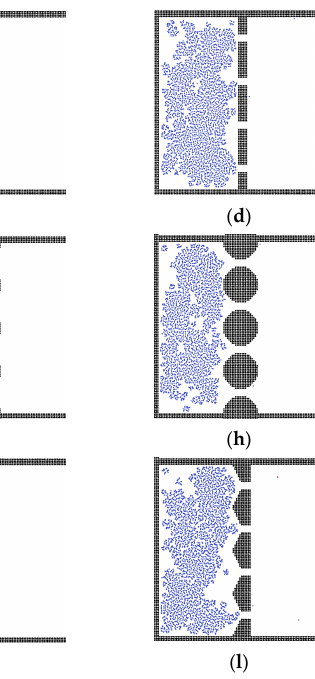
Figure 5. The results with different channel sizes; ( a , b,e , f , i , j ) with channel width of 12 μ m; ( c , d ), ( g , h , k , l ) and with channel width of 20 μ m. The fluid flow was affected by the channel surface, and we calculated different mod- els in order to explain the effects of membrane thickness. For the thin membrane structure, as shown in Figure 6, oil particles adsorb on the corner, which is similar to that previously discussed. However, using a thicker membrane structure, Figure 6d shows more residual oil particles, and the structure of the oil phase tends to form a layer. This is because the thicker membrane induces the stronger interaction force between fluid and solid wall par- ticles.